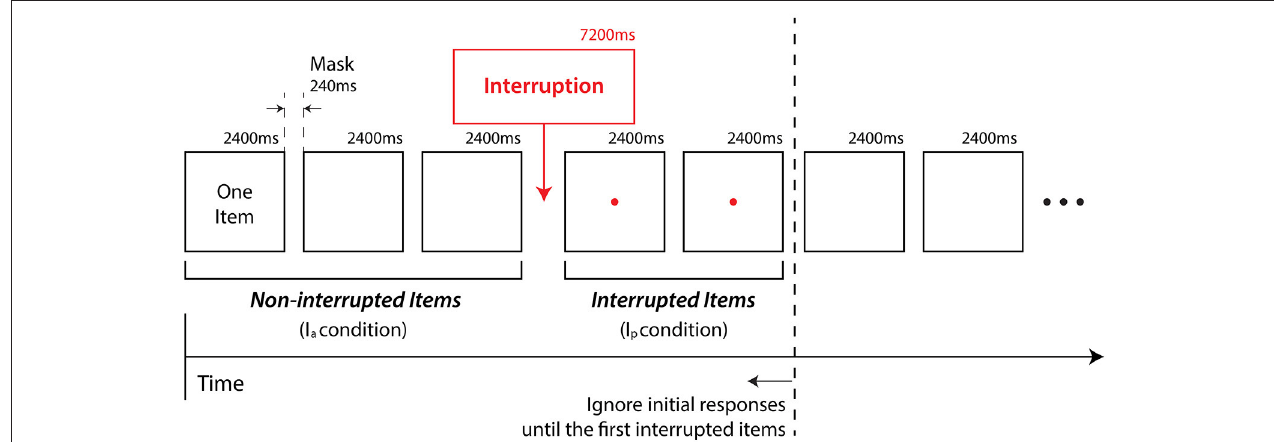
FIGURE 5 | Example sequence of two-back task items with